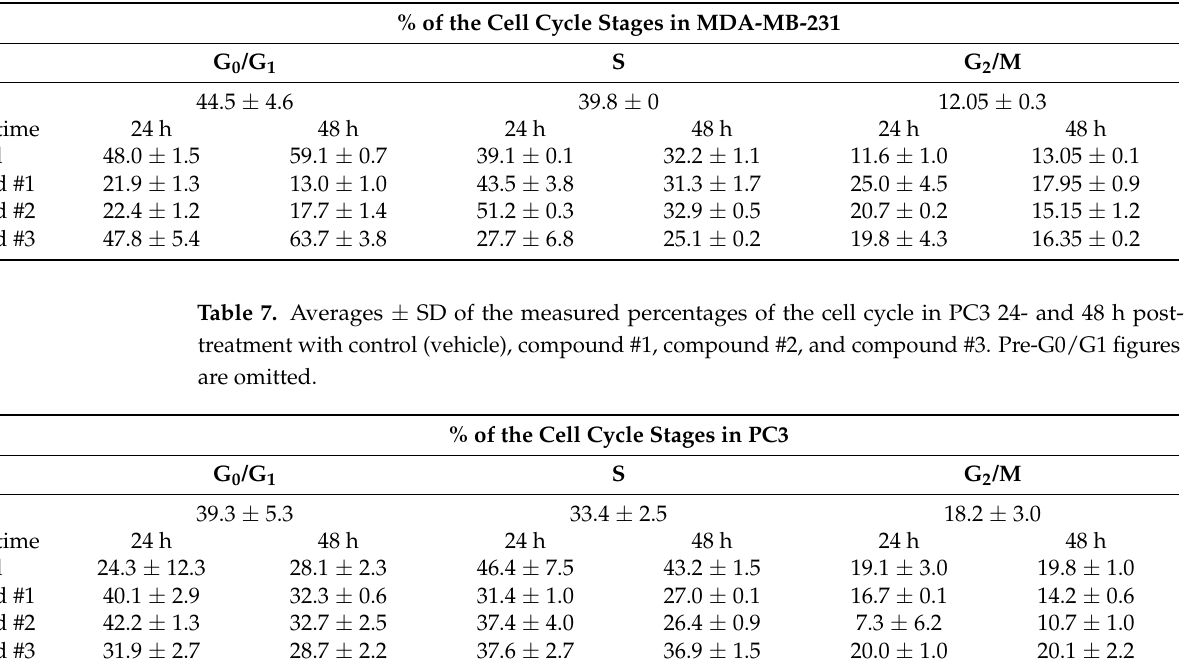
Table 6. Averages ± SD of the measured percentages of the cell cycle in MDA-MB-231 24- and 48 h post-treatment with control (vehicle), compound #1, compound #2, and compound #3. Pre-G0/G1 figures are omitted.